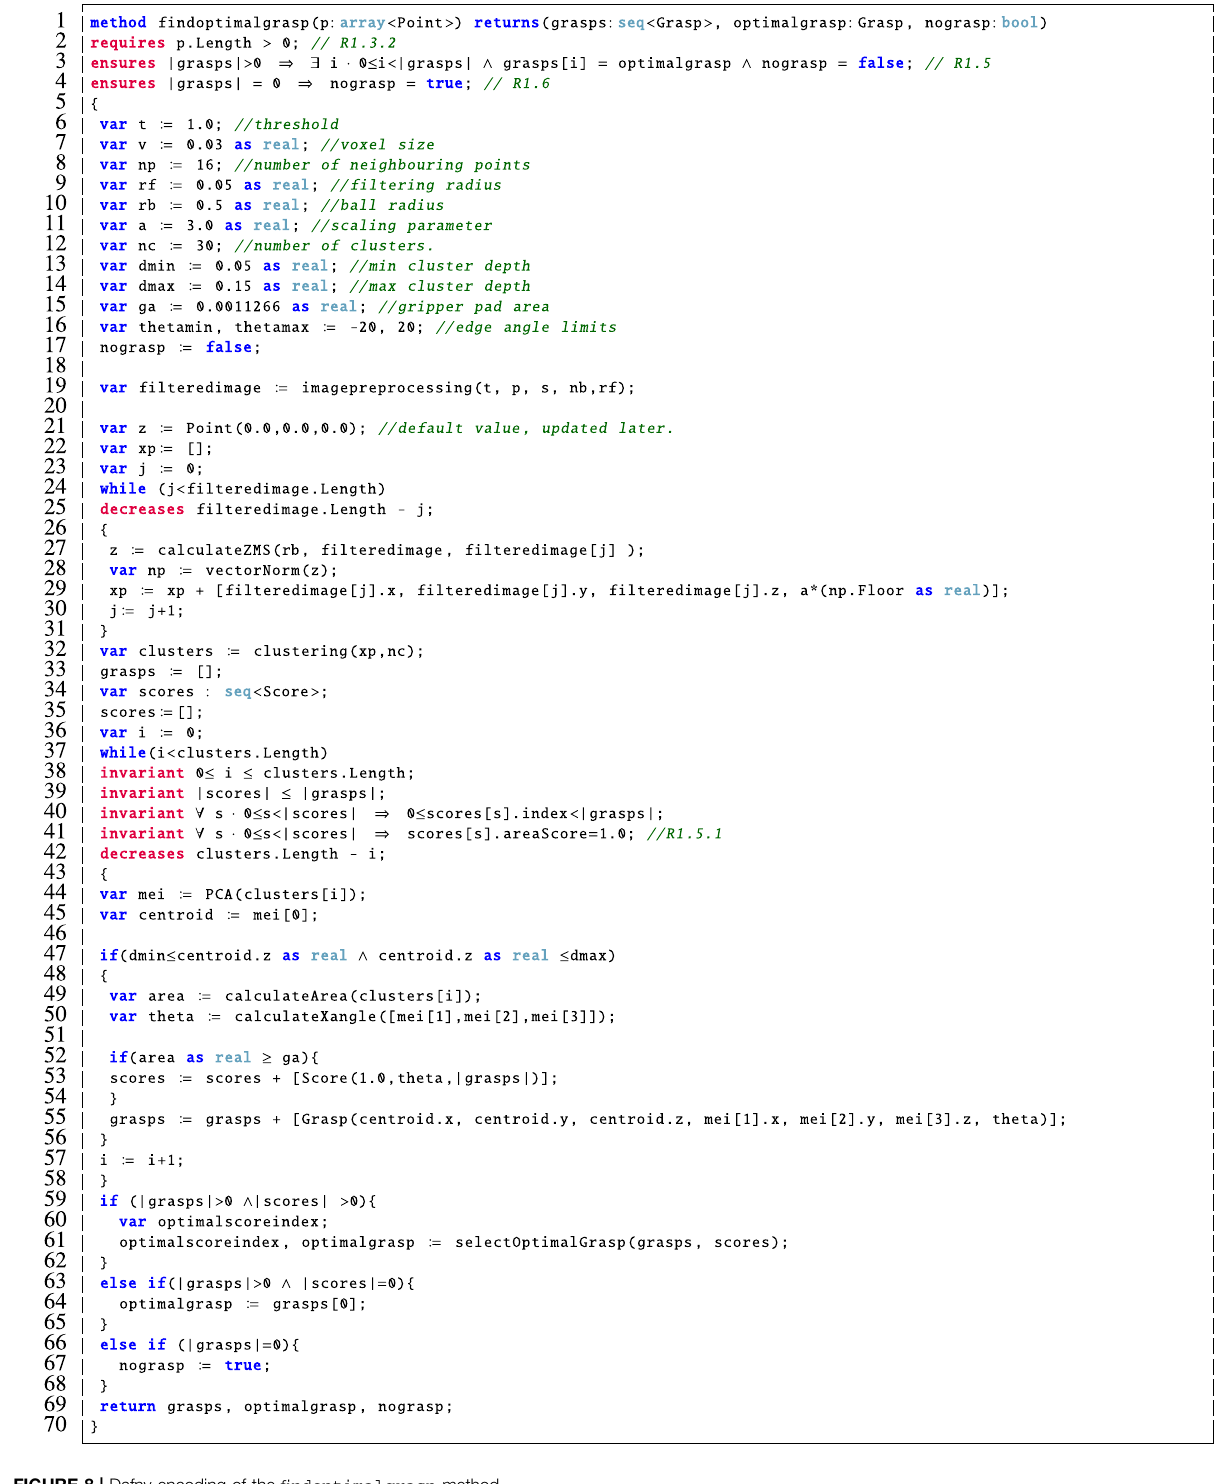
Frontiers in Robotics and AI |